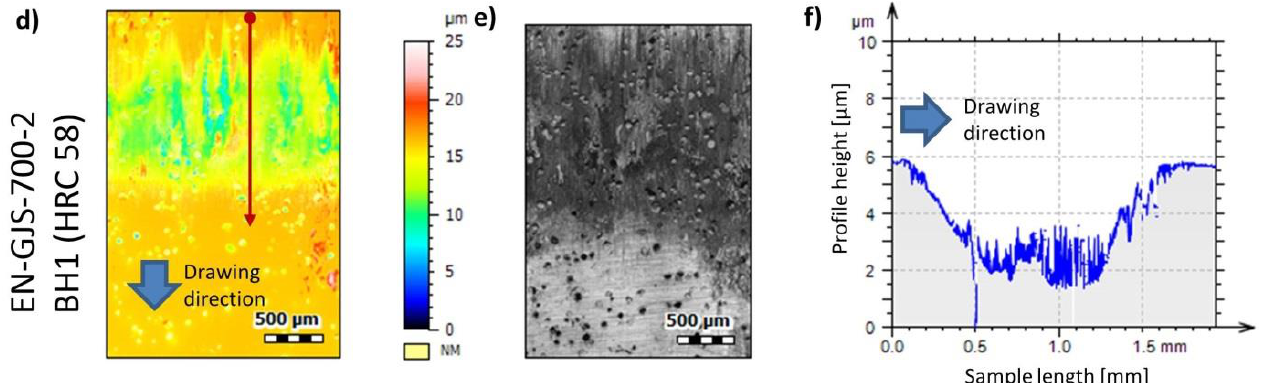
Figure 28. ( a ) Surface topography; ( b ) Surface photo; ( c ) 2d profile of the wear mark on Die1 of cold working steel; ( d )